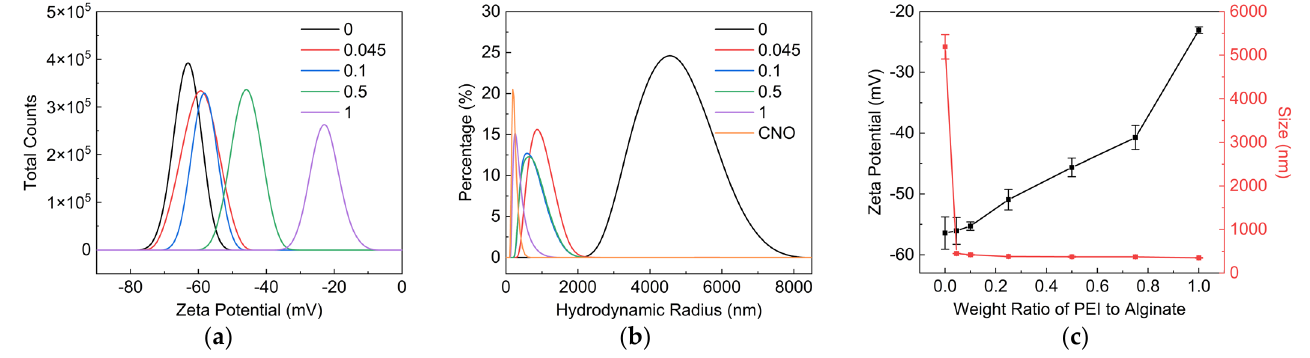
Figure 5. Characterization of CNO/SA/PEI dispersion with weight ratio of PEI to SA. ( a ) Zeta potential, ( b ) hydrodynamic size distribution and ( c ) average Zeta potential and hydrodynamic size of CNO/SA/PEI dispersion.